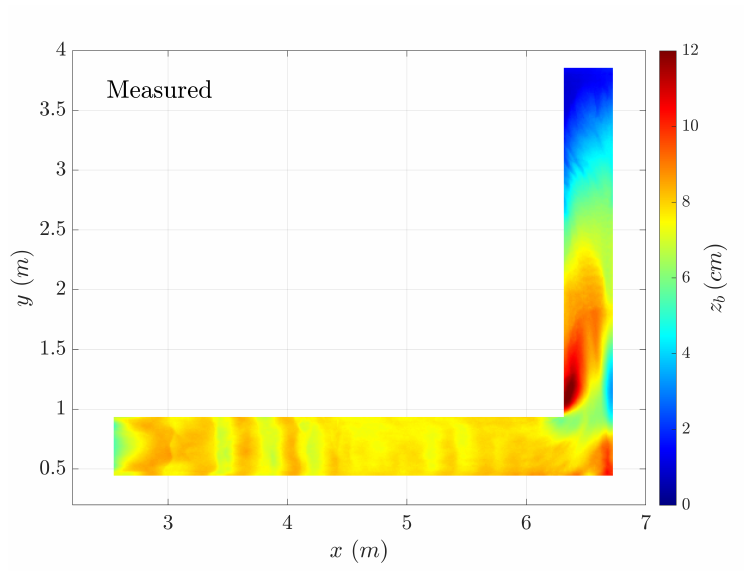
Figure 2. Final topography obtained after the channel drainage using photogrammetry and averaged over the three experimental runs available.